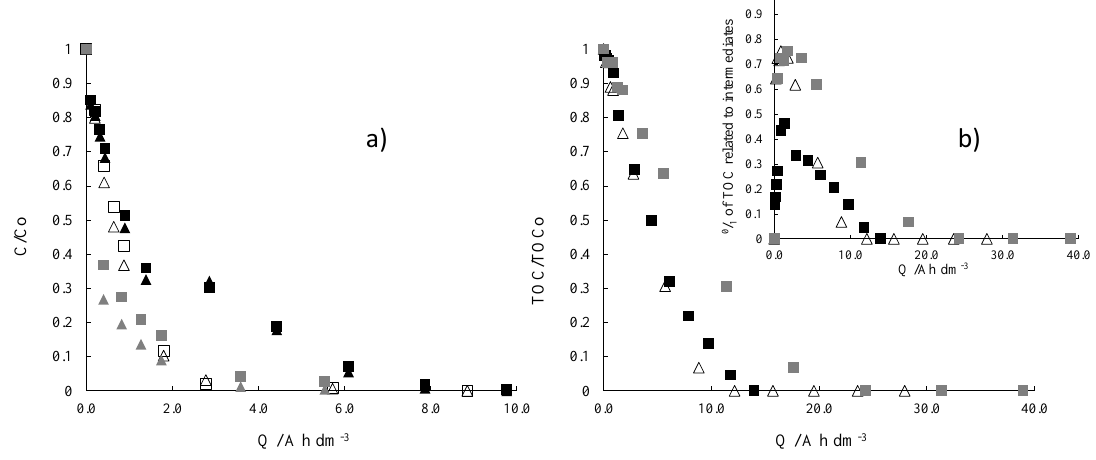
Figure 1. Oxidation trends of the antibiotics amoxicillin (AMX) ( (cid:78) , ∆ , (cid:78) ) and ampicillin (AMP) ( (cid:4) , (cid:3) , (cid:4) ) ( a ) and of total organic carbon (TOC) ( b ) with the electric charge passed during the electrolysis carried out in sulphate media (3 g L − 1 of Na 2 SO 4 ) at three current densities: 15 (black symbols), 30 (white symbols), and 60 (grey symbols) mA cm − 2 . Initial concentration was 100 mg L − 1 of AMX and 100 mg L − 1 of AMP.